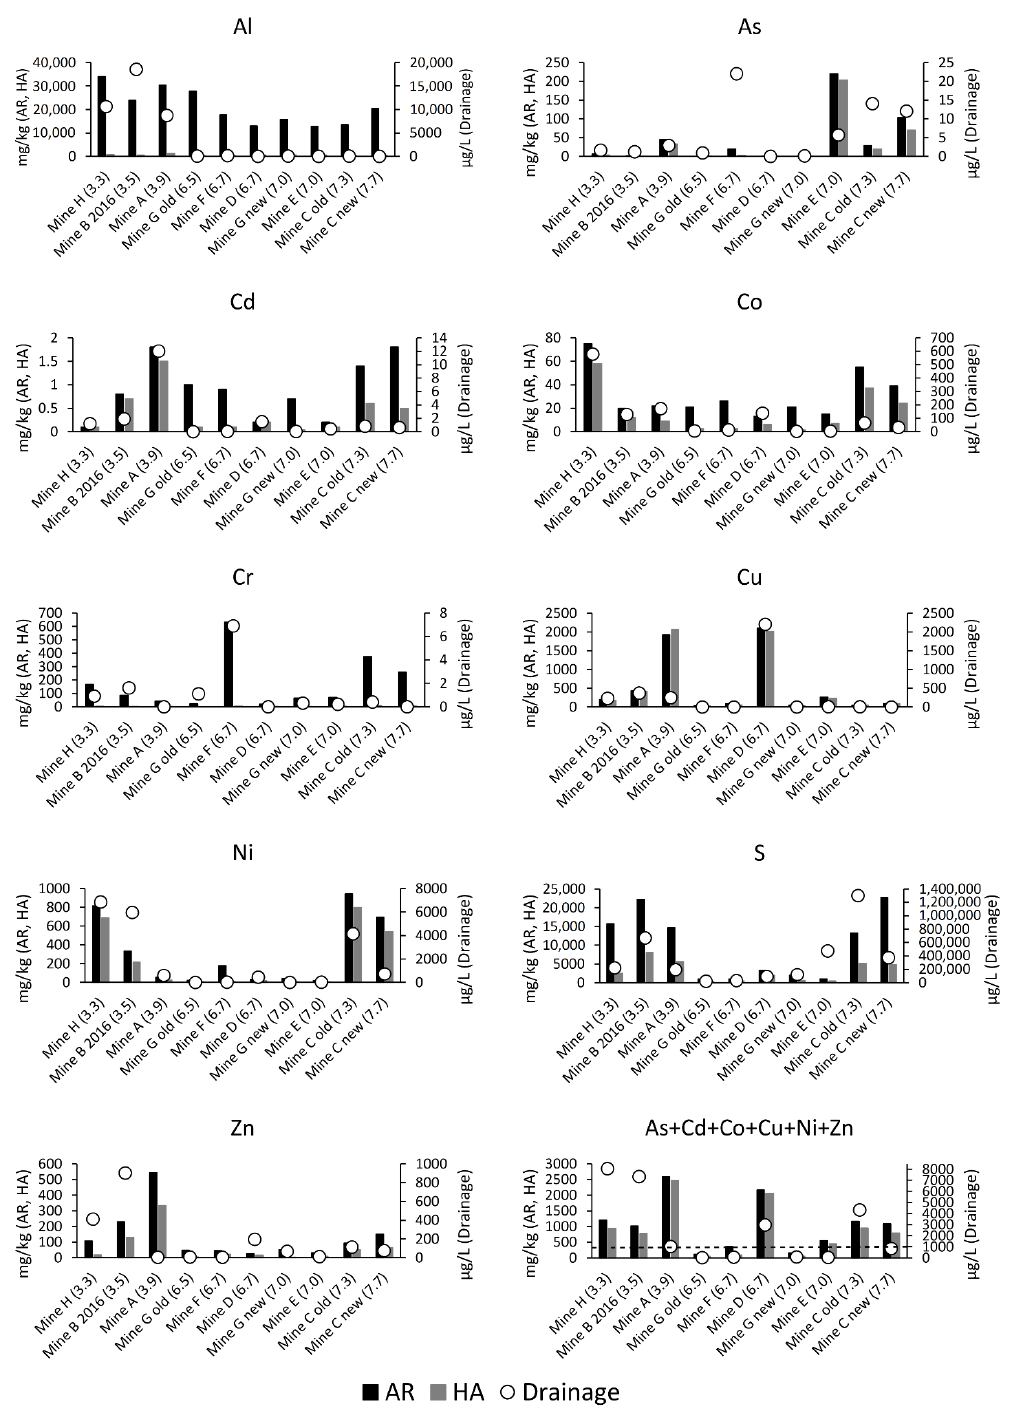
Figure 4. The HA and AR extractable concentrations of Al, As, Cd, Co, Cr, Cu, Ni, S, Zn and the sum of the As, Cd, Co, Cu, Ni and Zn concentrations in composite waste rock samples (histograms) and in the corresponding drainage water samples (dots). The drainage pH values are shown in brackets after the sample name. The samples are presented in the order of increasing drainage pH. Drainage and AR leach data are reported by Karlsson et al. [18]. The dashed black line presents 1000 µg/L in drainage for the sums of As, Cd, Co, Cu, Ni and Zn.